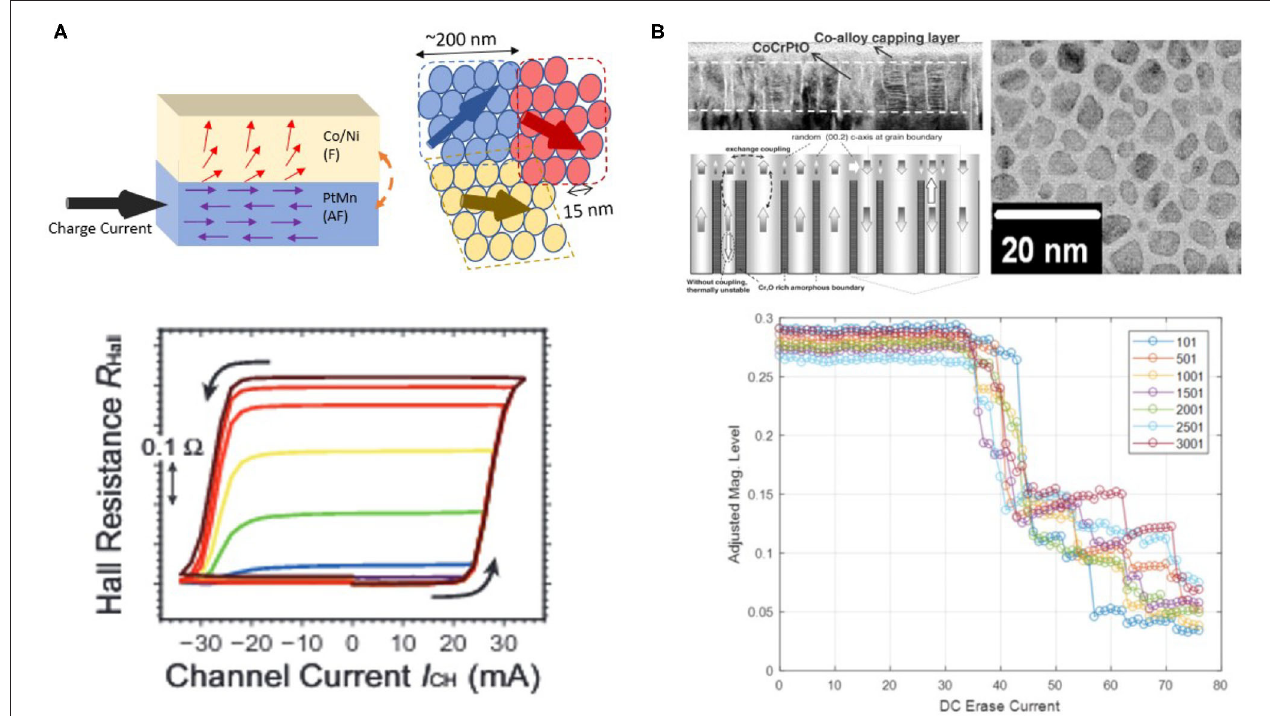
FIGURE 5 | (A) Exchange-coupled F/AF bilayer structures with multi-level states. The top panel illustrates the bilayer structure and magnetic configurations, while the bottom panel shows multi-level Hall resistance and hysteresis loop. Figure adapted with permission from Borders et al. Appl. Phys. Express 10 013007 (2017). (B) Exchange-coupled continuous-granular structures with multi-level states. The top panel shows the material structure of the continuous/granular composite, while the bottom panel shows multi-state magnetization under an increasing writing field. Figure adapted with permissions from Choe et al. IEEE Trans. Mag., 41, 3172–3174 (2005) Copyright 2005 IEEE, Tham et al. IEEE Trans. Mags. 43, 671–675 (2007) Copyright 2007 IEEE, and Wang et al. U.S. Patent Application No.